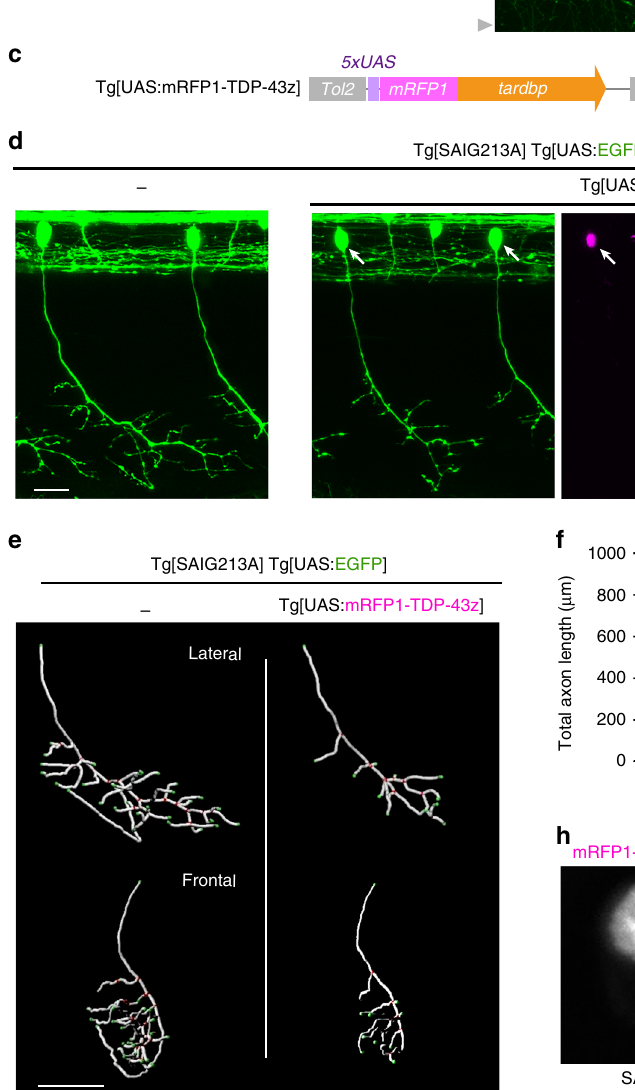
opTDP-43z (i.e., optogenetic TDP-43 of zebra fi sh) (Fig. 2a). When expressed via mRNA injection at the one-cell stage, opTDP-43z rescued the blood circulation defect of TDP-43DKO embryos under dark conditions as ef fi ciently as wild-type tardbp (Supplementary Fig. 1e, Supplementary Movie 1), con fi rming that